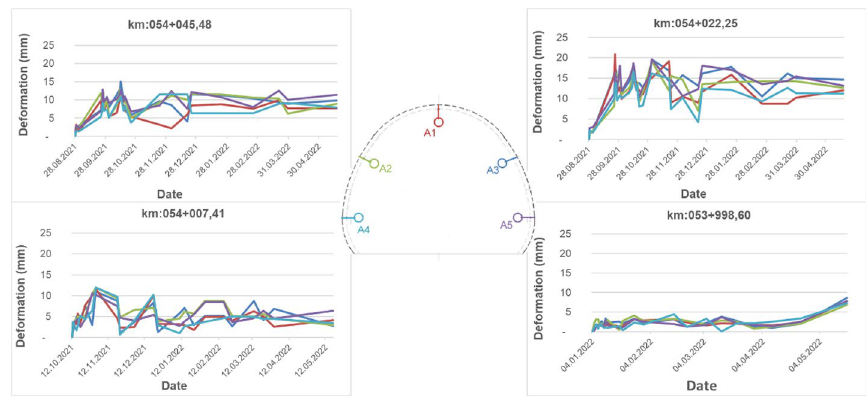
Fig. 16 Deformation monitoring points and measurement graphs